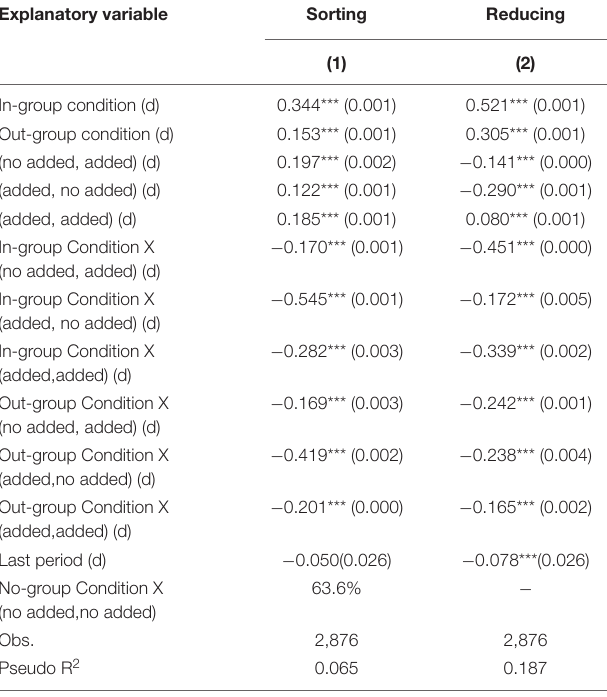
TABLE 12 | Group condition and the combination of income changes Probit regressions on two PEBs. Explanatory variable Sorting Reducing